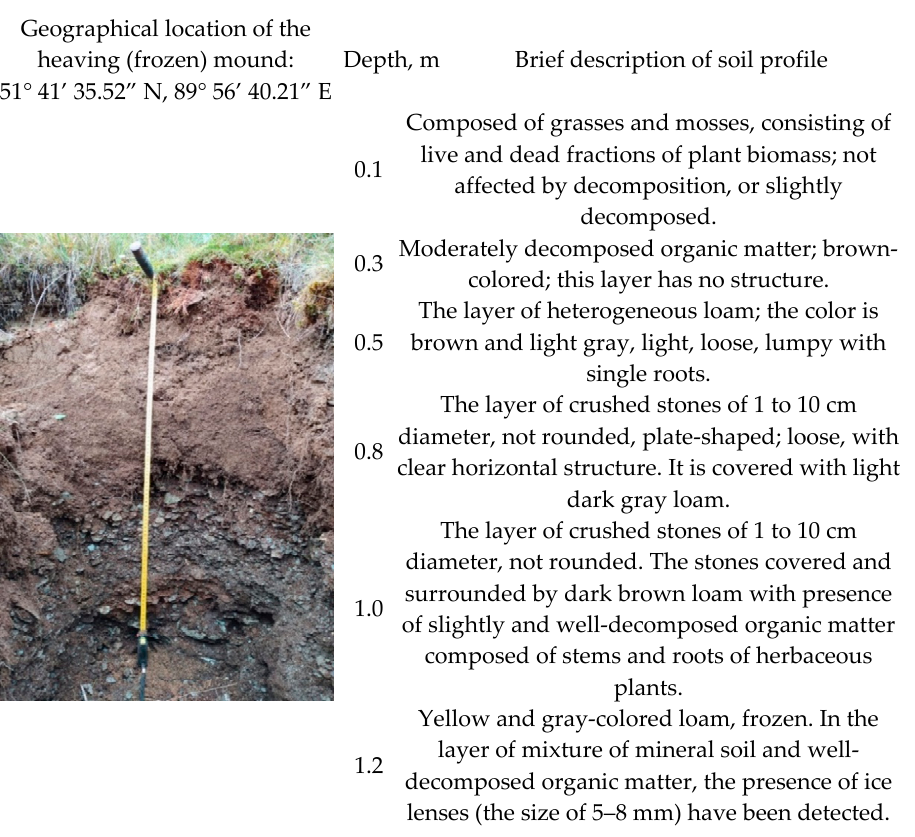
Figure 5. The soil profile at heaving (frozen) mound in Adyr-Khem river valley. The palsa mire sites in Adyr-Khem river valley at Alash plateau; southern slope of the Western Sayan montane